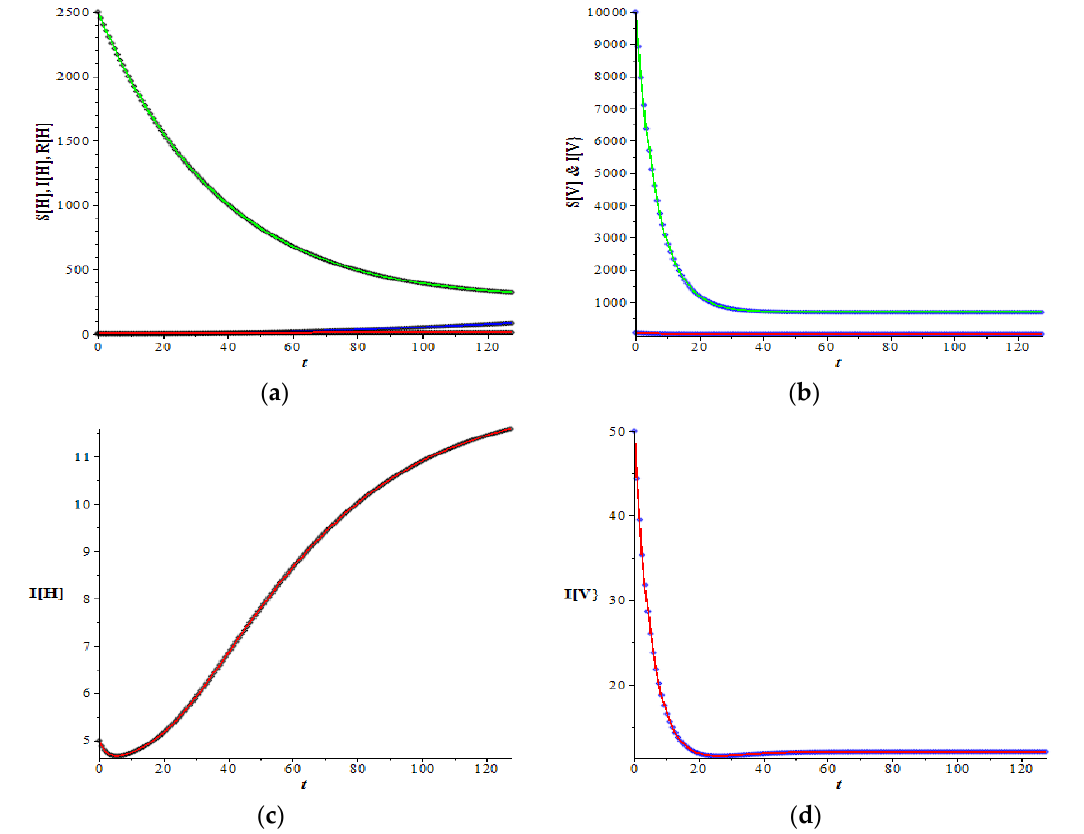
Figure 3. ( a ) shows the graphs of S H ( t ) , I H ( t ) , and R H ( t ) , while ( b ) shows the graphs of S V ( t ) and I V ( t ) with the explanation as in Figure 1. To compare the number of infected humans and mosquitoes, we plot I H ( t ) in ( c ) and I V ( t ) in ( d ). Here, we use the data set which has a medium basic reproduction number, i.e., R 0 = 2.772.